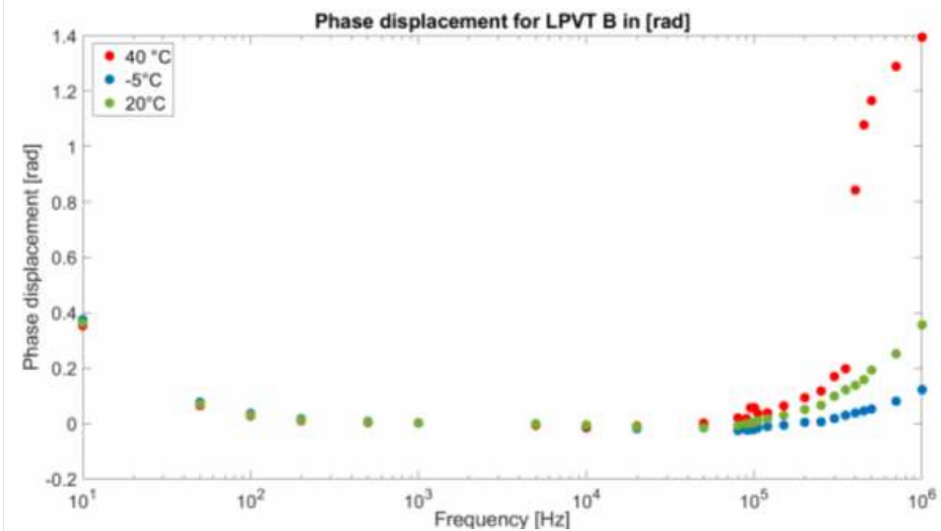
(cid:0) (cid:1) V p expressed in radians for LPVT B as a function of the frequency f at